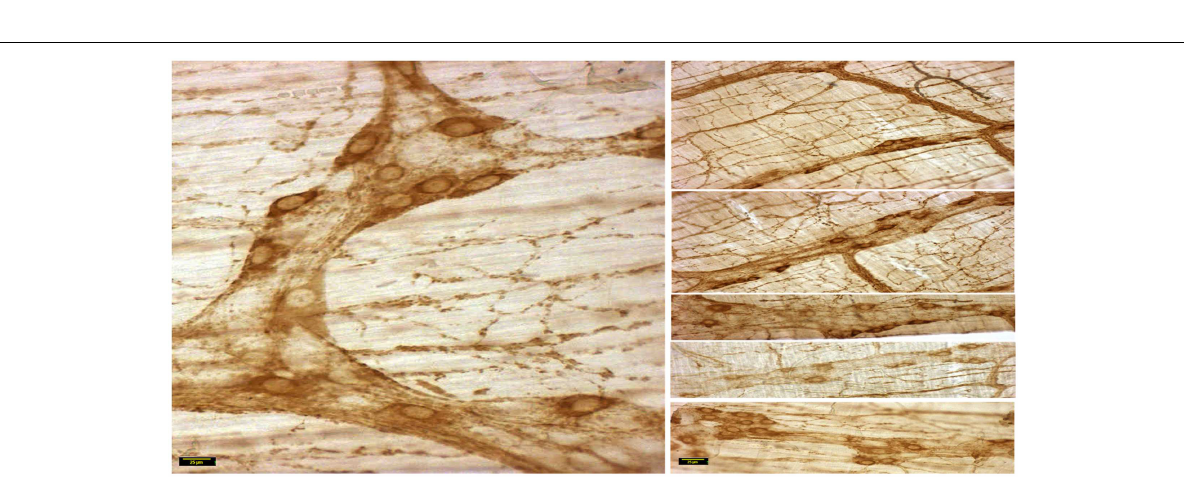
count 153AU/ µ m 2 ), cumulative analyses show comparable lev- els of the space occupancy of nitrergic varicosities (215.25 ± 0.74 vs. 209.84 ± 0.82AU/ µ m 2 , p = 0.42, two-tailed t test) ( Figures 9A and 9C ).